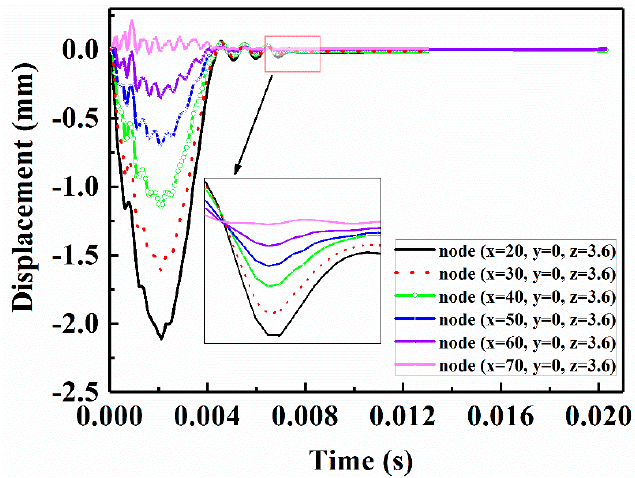
Figure 18. Displacement-time curves of six random nodes during the vibration damping step.